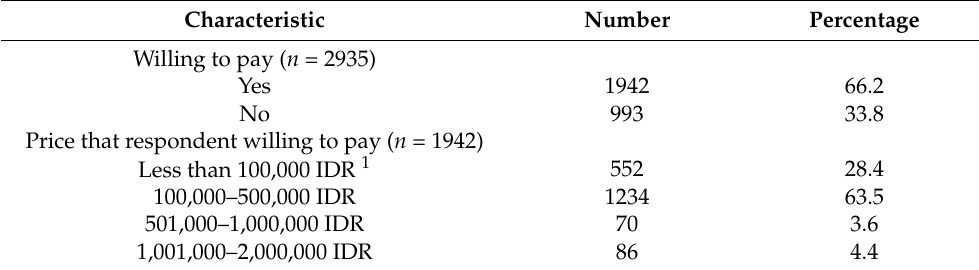
Table 1. Willingness to pay and the prices the participants were willing to pay for a booster dose of COVID-19 vaccine ( n = 2935).